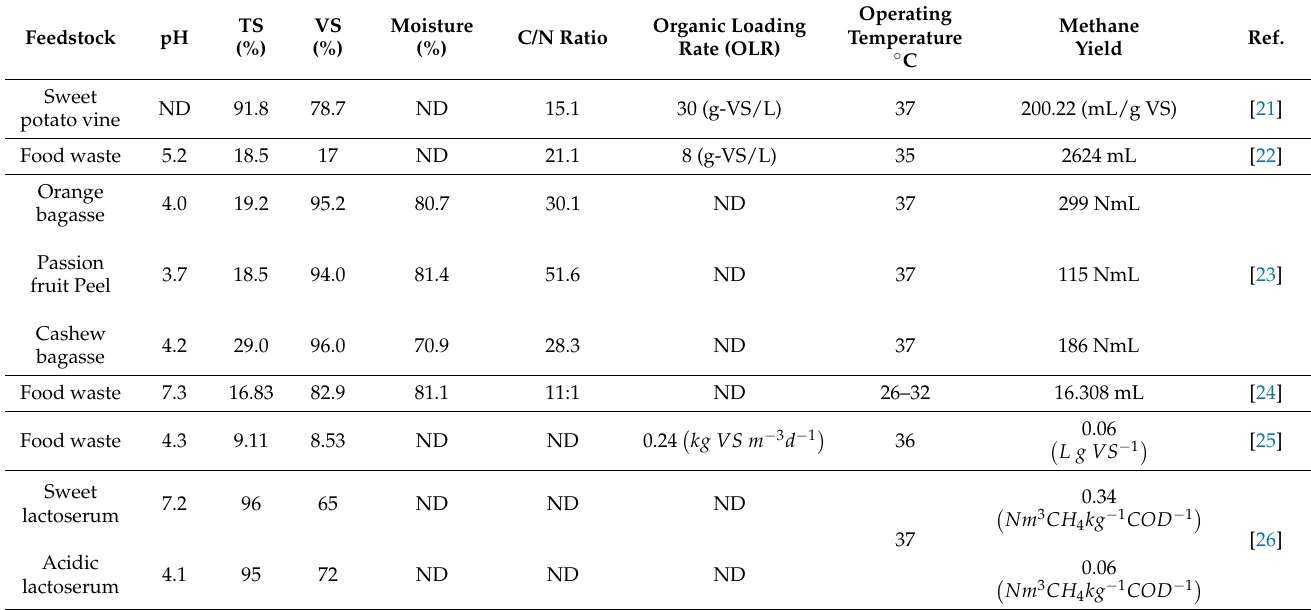
Table 1. Different FW feedstock with methane